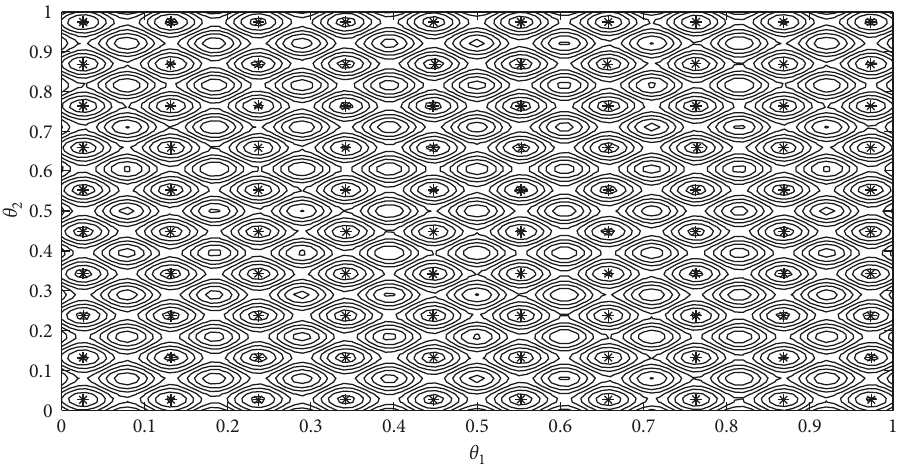
Figure 9: Multiple solutions for two variable functions with 5000 population